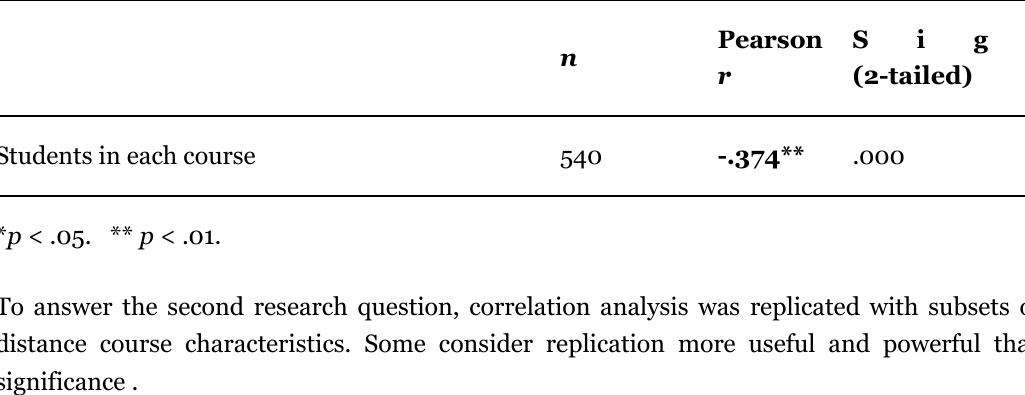
Relationship between Sequential Movement and Successful Completion